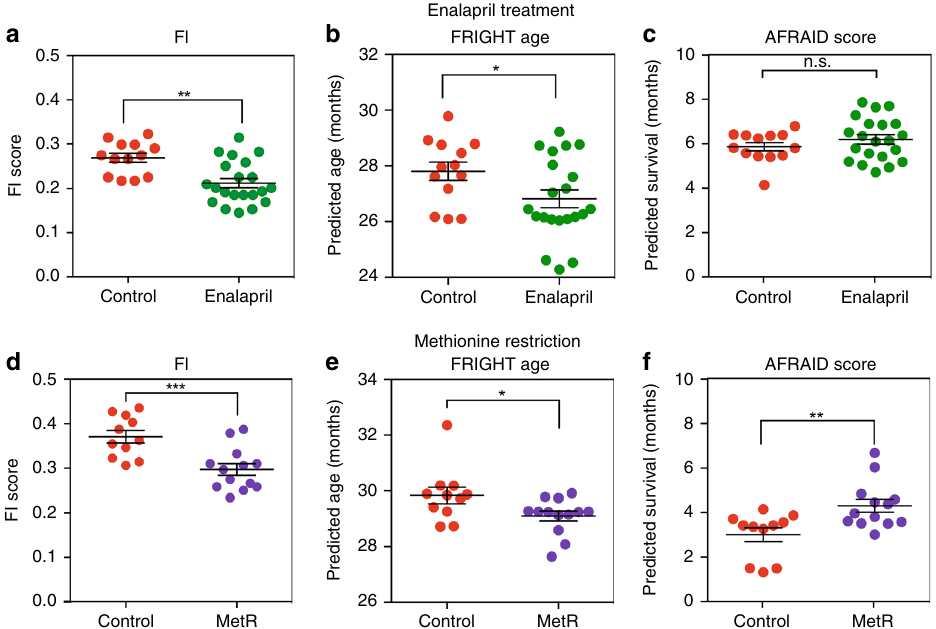
Fig. 5 Response of FRIGHT age and AFRAID clock to interventions. a – c Frailty Index (FI) score, FRIGHT ( Fr ailty I nferred G eriatric H ealth T imeline) age and AFRAID ( A nalysis of Frai lty and D eath) clock for male 23-month-old C57BL/6 mice treated with enalapril-containing food (280mg/kg) or control diet from 16 months of age. Data reanalyzed from previously published work 21 . Control n = 13, Enalapril n = 21. Exact p values, respectively: 0.001, 0.046, 0.29. d – f FI score, FRIGHT age, and AFRAID clock for male 27-month-old C57BL/6 mice treated with either a control diet (0.45% methionine) or methionine-restricted diet (0.1% methionine, MetR) from 21 months of age. * p value <0.05, ** p <0.01, and *** p <0.001 compared with independent two-sided t -tests. Control n = 11, MetR n = 13. Exact p values, respectively, 0.001, 0.039, 0.006. Error bars represent standard error of the mean. Source data are provided as a Source Data fi